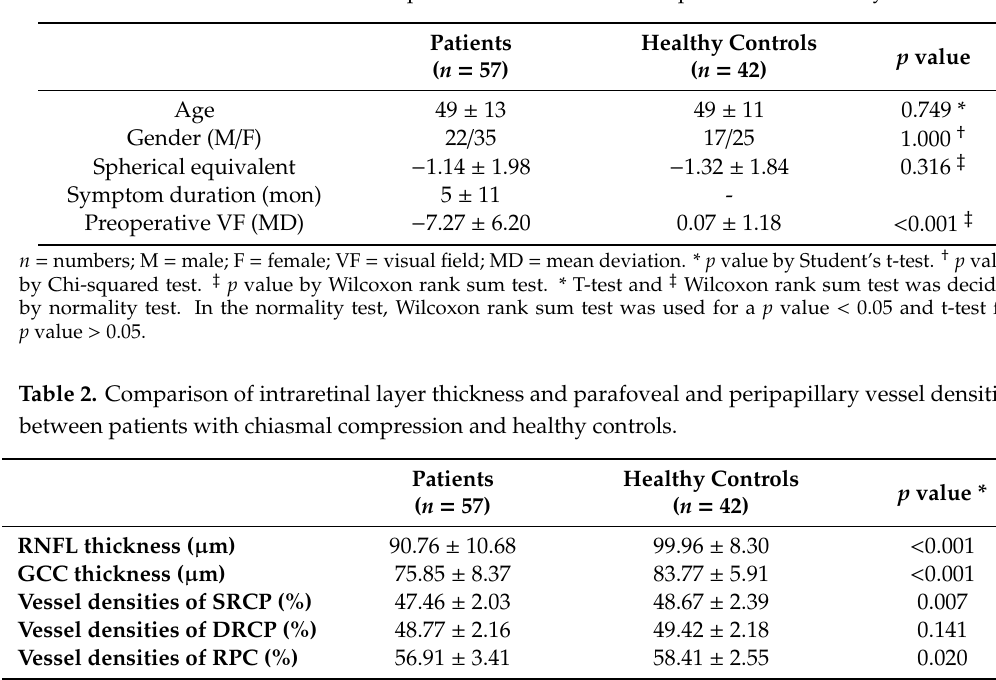
Table 1. Baseline characteristics of patients with chiasmal compression and healthy controls.